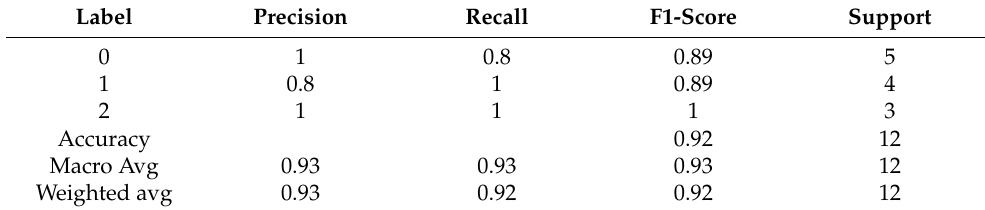
Table 5. Classification report (random forest).